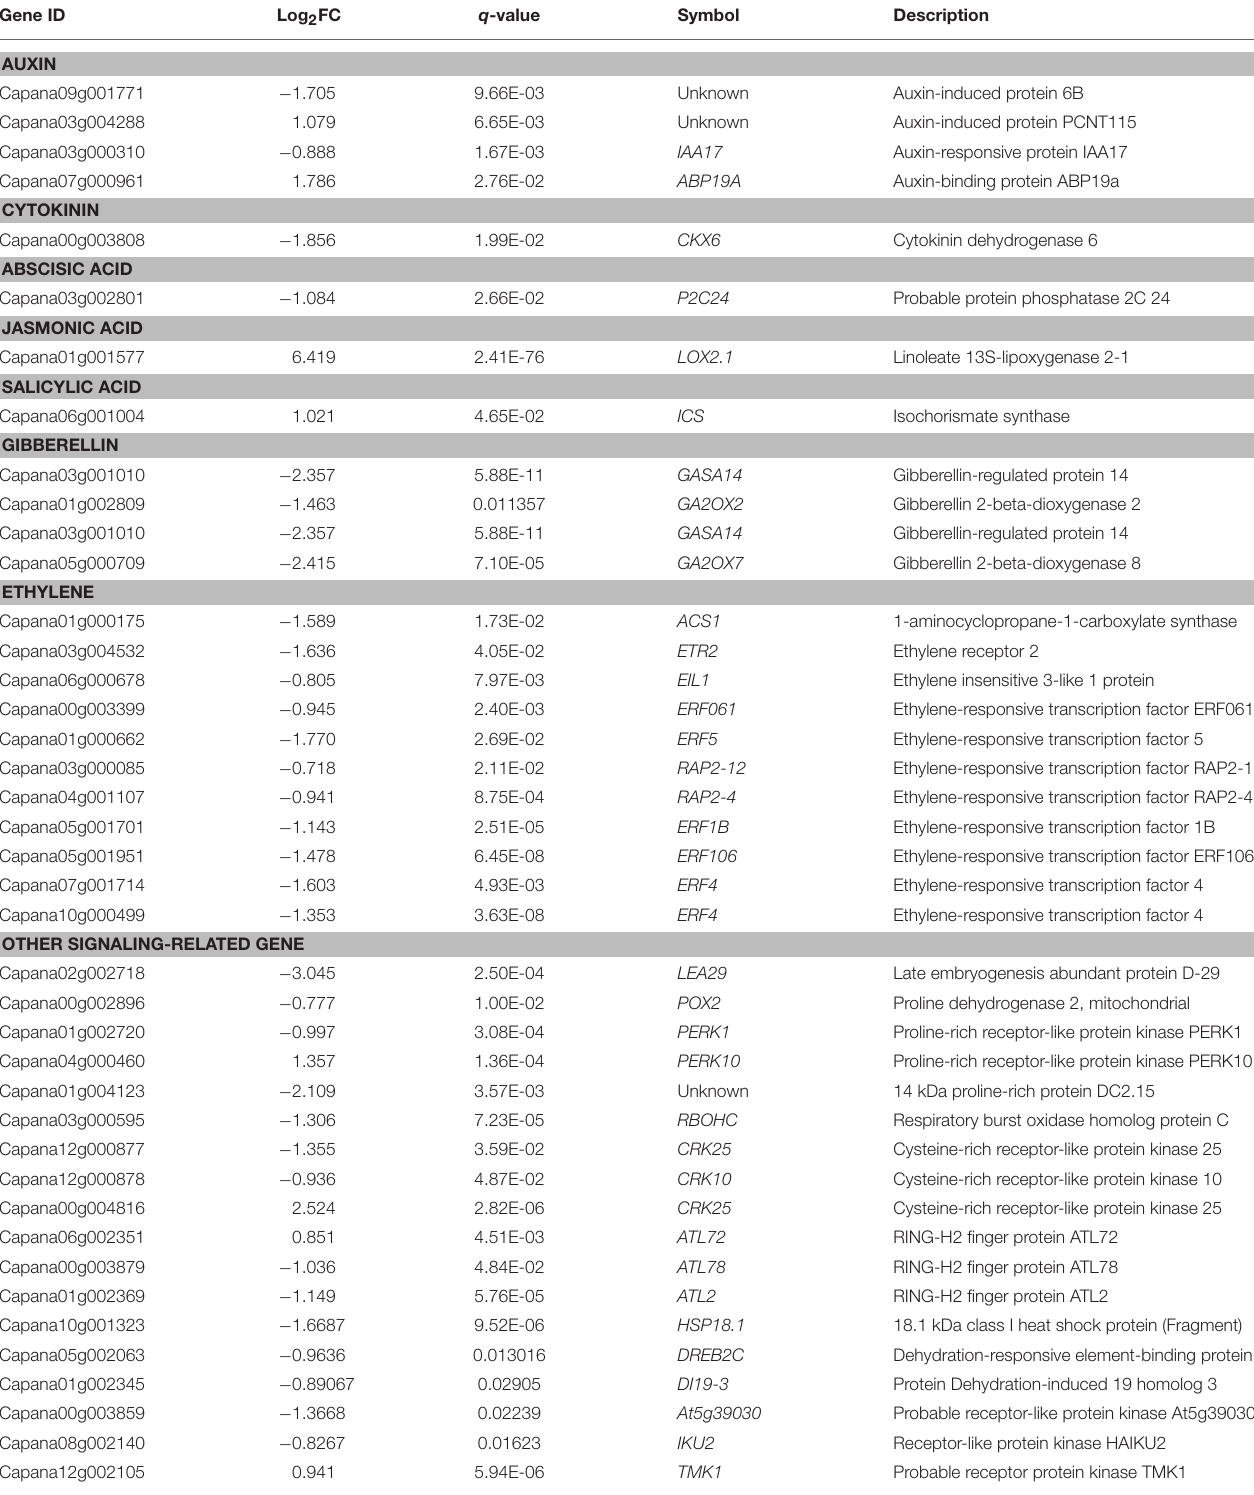
TABLE 5 | Hormone metabolism and signaling-related gene expression in pepper leaves as influenced by chilling alone or in combination EBR treatment. Gene